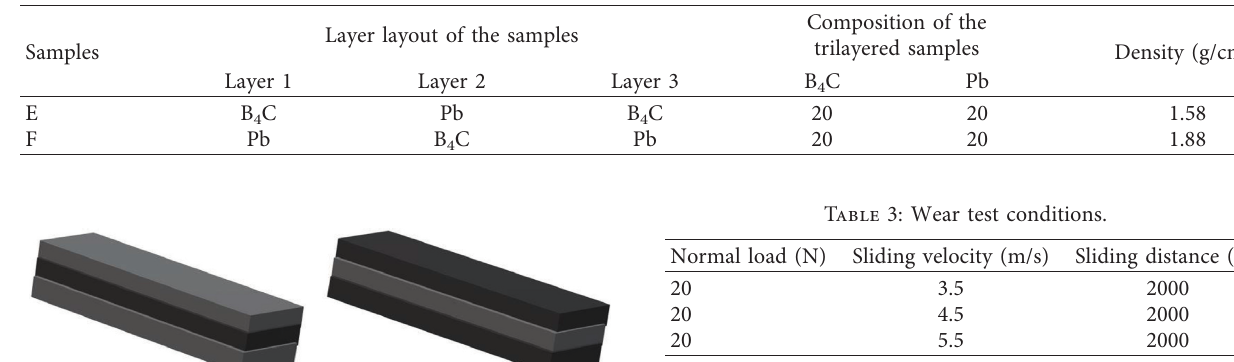
Table 2: Composition of trilayered samples and the density of the samples.